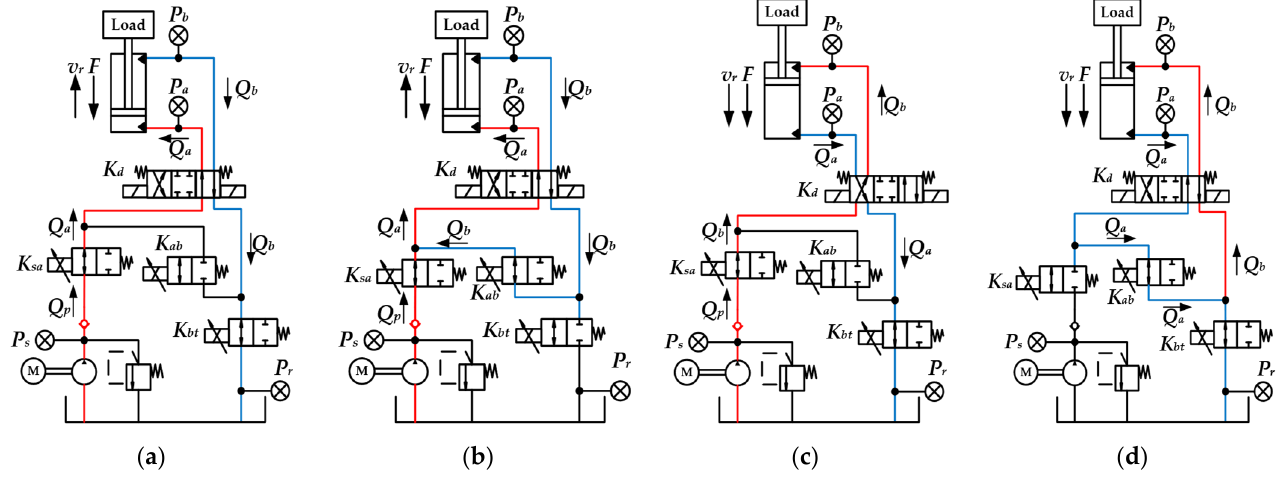
Figure 2. Metering modes of the NIMV, PE mode ( a ), HSRE mode ( b ), PR mode ( c ), and LSRR mode ( d ).